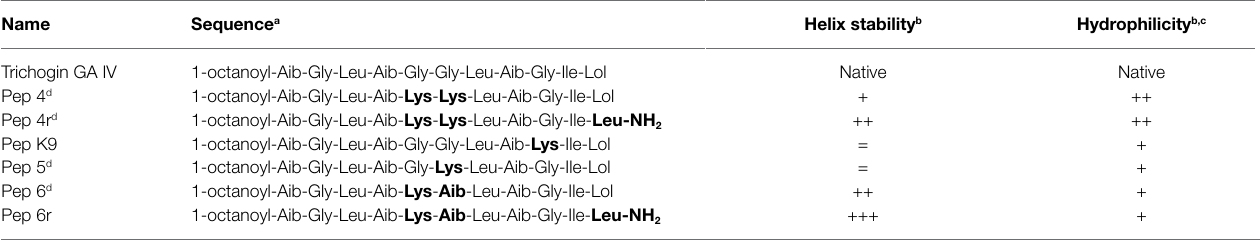
TABLE 1 | Sequence and chemical features of Trichogin GA IV-derived peptides tested in the present